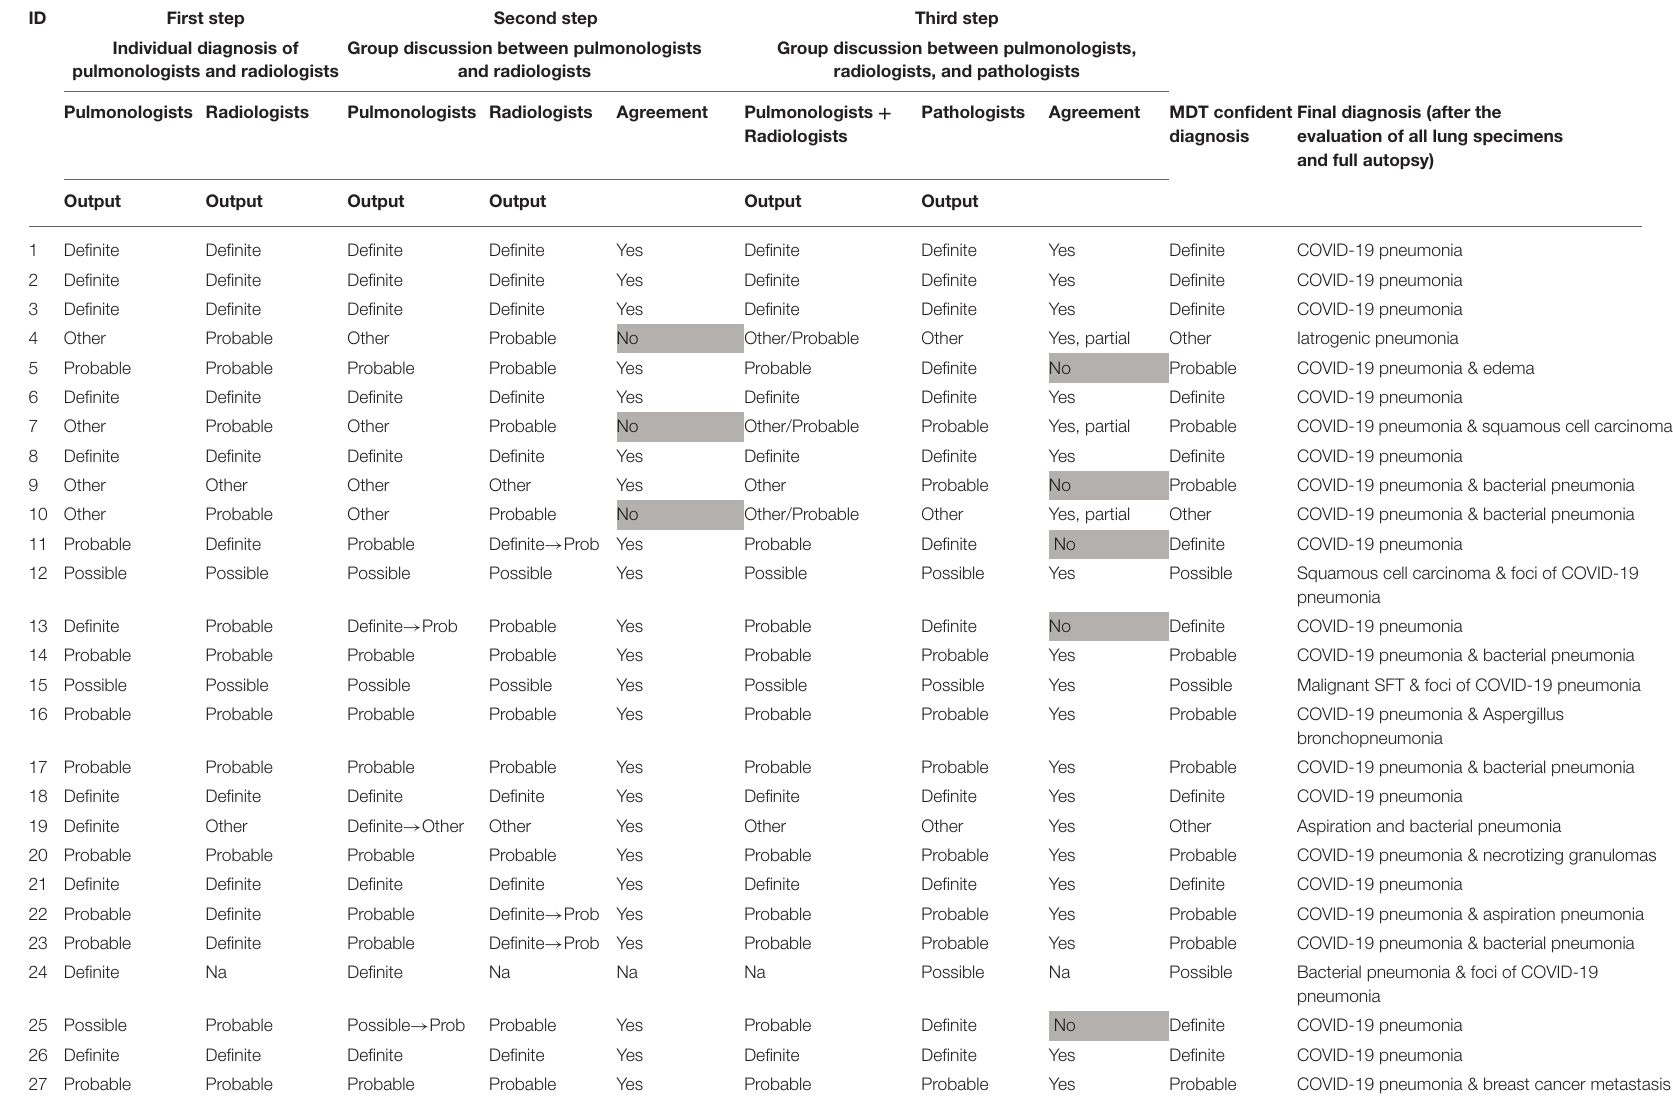
TABLE 2 | Confident diagnoses achieved step by